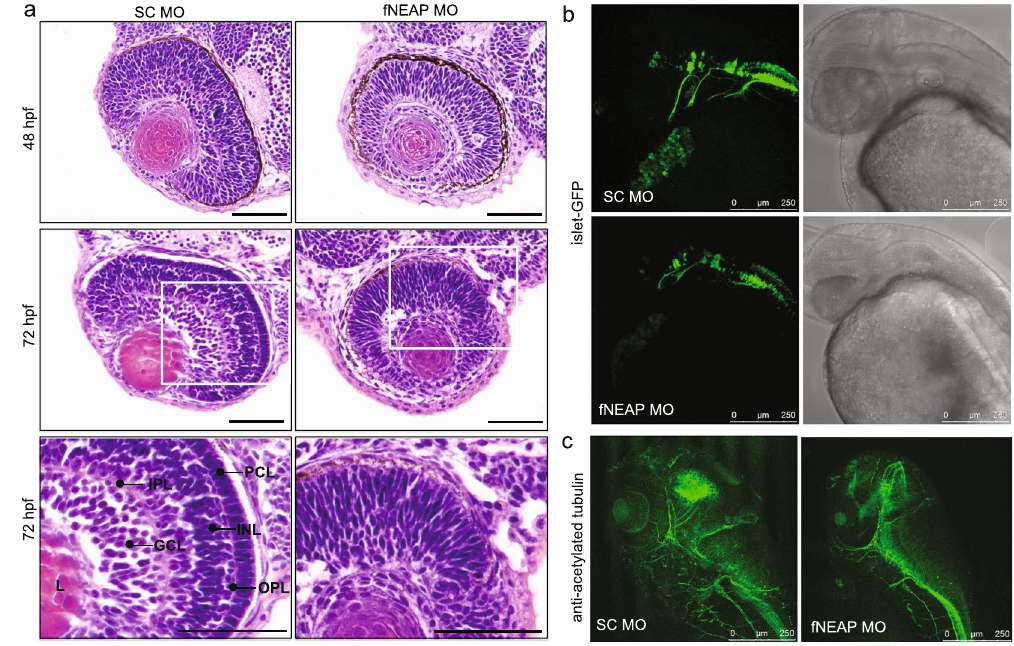
Figure 7. NEAP deficiency causes defects in retina and motor neuron development. ( a ) Zebrafish embryos treated with SC or fNEAP MO (12 ng) were collected at 48 or 72 hpf and subjected to histological analyses as described in the Methods. The development of zebrafish retina was shown with hematoxilin & eosin staining. Scale bars: 50 μ m. Abbreviations: gcl, ganglion cell layer; inl, inner nuclear layer; ipl, inner plexiform layer; opl, outer plexiform layer; pcl, photoreceptor cell layer. ( b ) Islet-GFP transgenic zebrafish embryos treated with SC or fNEAP MO (12 ng) were subjected to microscopic analyses. The development of fluorescent cranial motor neurons and head morphology were documented by fluorescent (left panels) and phase contrast (right), respectively. ( c ) Zebrafish embryos treated with SC or fNEAP MO were subjected to in situ immune- fluorescence staining using an anti-acetyl tubulin